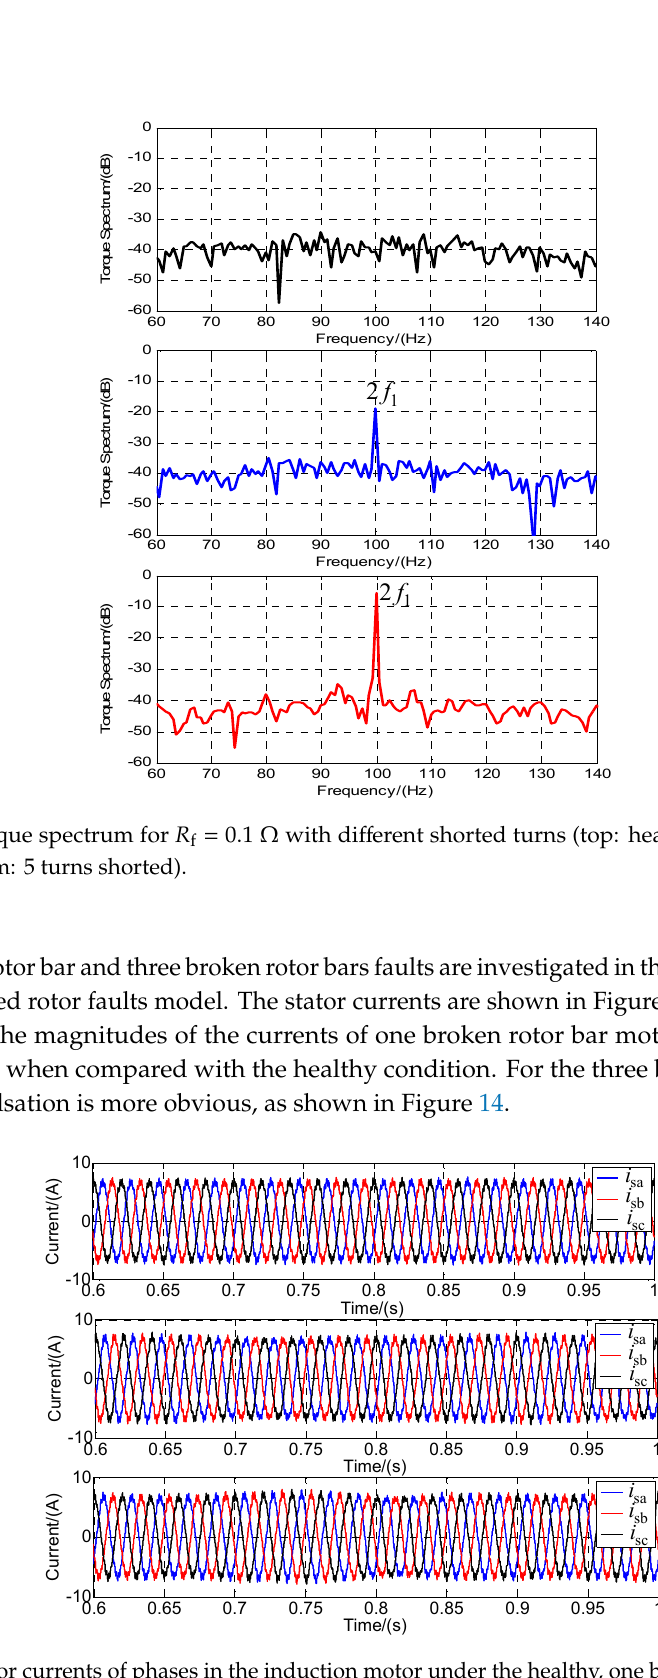
Figure 12. Currents of stator phases for R f = 0.1 Ω with different shorted turns.